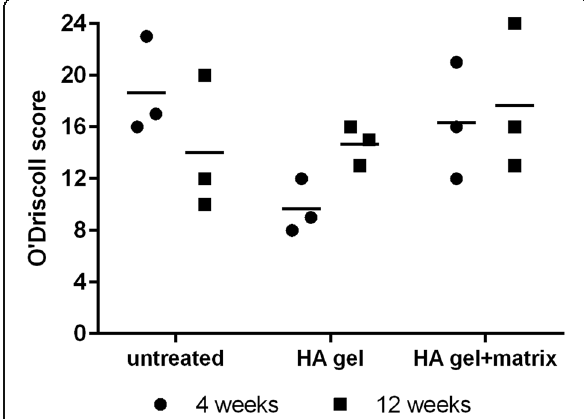
Fig. 4 Cartilage repair score of the regenerated tissue. Individual scores are represented as dots (4 weeks) and squares (12 weeks) with the arithmetic mean of the untreated and treated groups shown as horizontal bars . The scores (maximum 24) represent the quality of the repaired cartilage tissue and is characterized by cellular morphology, safranin-O staining, surface regularity, structural integrity, thickness, bonding to the adjacent cartilage, hypocellularity, chondrocyte clustering and freedom from degenerative changes in adjacent cartilage. No significant (n.s.) difference within a group or between the